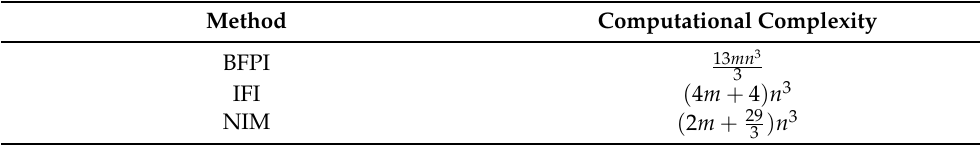
Table 3. The computational complexity of BFPI, IFI, and